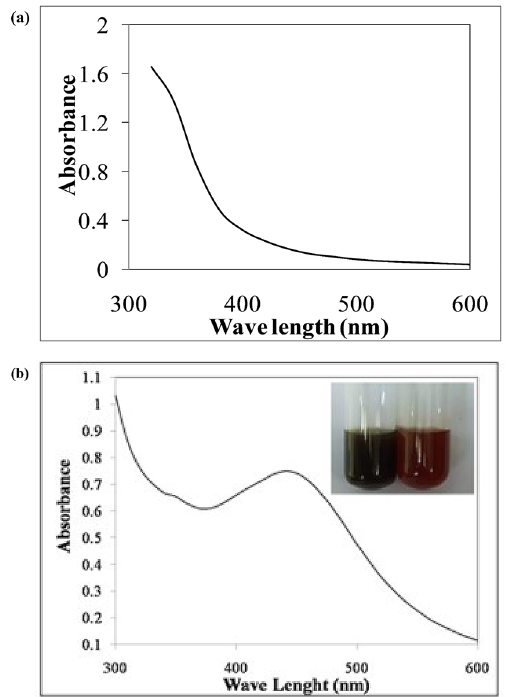
Fig. 1 a AgNPs UV–Visible spectrum of M. wightii leaf extract. b AgNPs UV–Visible spectrum of synthesized through green approach by M. wightii leaf